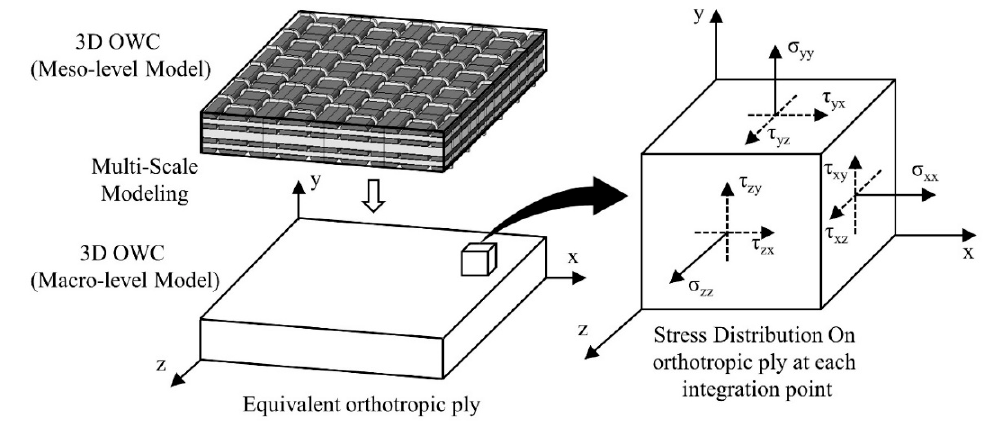
Figure 2. The equivalent orthotropic ply of 3D-FRC.